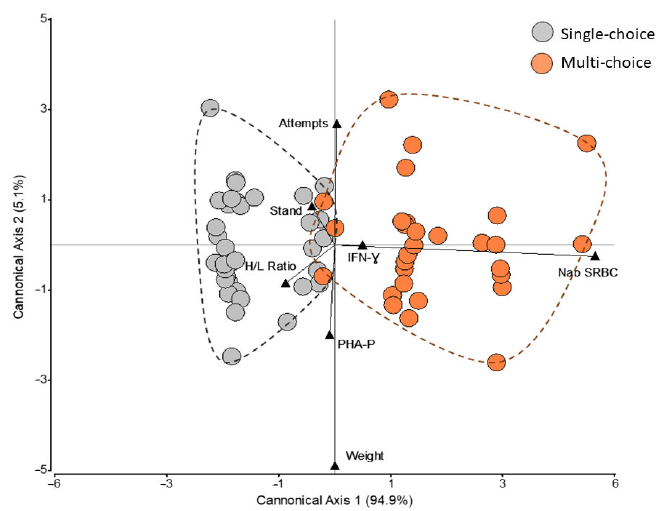
Figure 6. Exploration of the discriminatory capacity of the two treatments. Lineal discriminant analysis, including the following standardized variables (shown in black triangles): inflammatory response against phytohaemagglutinin-p (PHA-P), natural antibody titer against sheep red blood cells (Nab SRBC), heterophil/lymphocyte (H/L) ratio, IFN- G plasmatic concentrations (IFN- G ), latency to stand up in a tonic immobility test (Stand), and number of attempts to induce the TI state (Attempts) and weight gain (Weight). Each dot represents a laying hen chick in the study for which the register of all variables was complete. Grey dots represent chicks reared in the “single-choice” environment (37 chicks were analyzed), whereas orange dots represent chicks reared in the “multi- choice” environment (32 chicks were